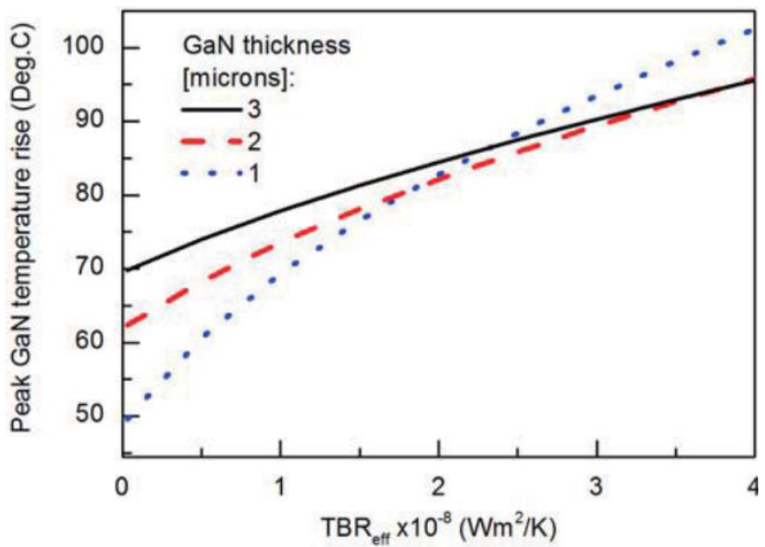
Figure 25. Peak channel temperature of a 4 × 125 µ m/40 µ m gate pitch GaN-on-diamond HEMT dissipating 10 W/mm for different TBR GaN/diamond values and GaN layer thicknesses (Copyright © 2014 IEICE. Reprinted, with permission, from M. Kuball, J. A. Calvo, R. B. Simon, and J. W. Pomeroy, “Novel thermal management and its analysis in GaN electronics,” Asia-Pacific Microw. Conf., pp. 920–922, 2014 [185]).